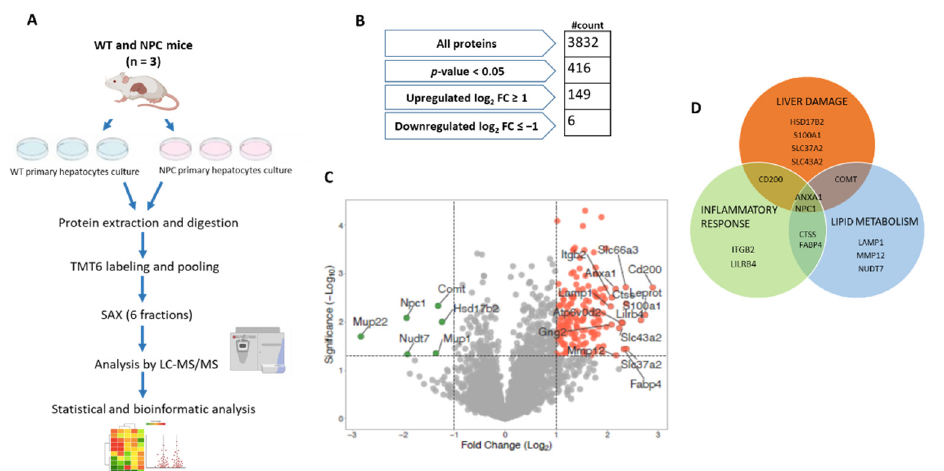
Figure 1. Proteomic analysis of a hepatocyte model of Niemann-Pick C disease. ( A ) Schematic representation of the experimental workflow. ( B ) Summary for the processing of data. ( C ) Volcano plot obtained from quantitative proteomics analysis. Red and green dots represent proteins that show a log 2 fold change ≥ 1 and log 2 fold change ≤ − 1. Proteins tagged show log 2 fold change ≥ 2 and log 2 fold change ≤ − 1. ( D ) Venn diagram depicting proteins tagged with a role in liver damage (orange circle), inflammatory response (green circle), and lipid metabolism (blue circle).